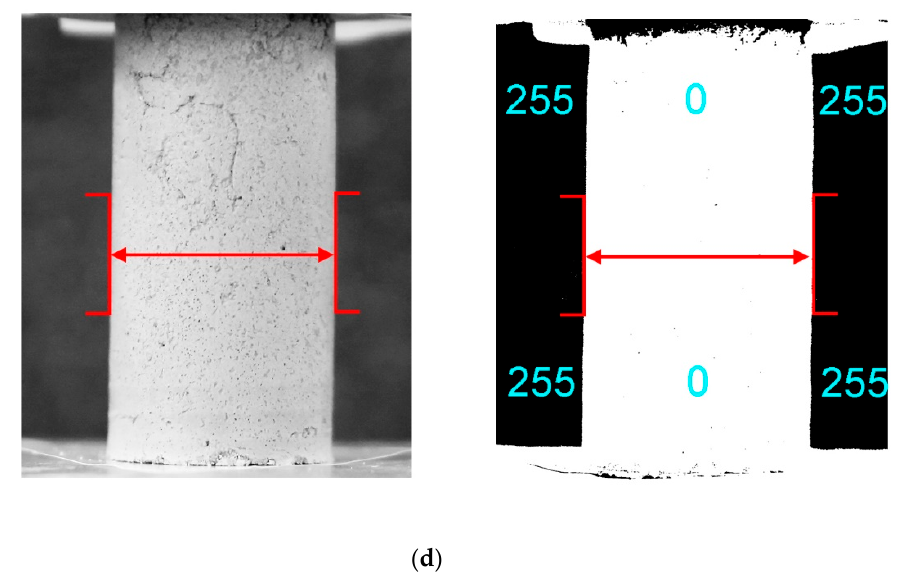
Figure 8. ( a ) The load and displacement curve of mixture MIX-L; ( b ) The load and displacement curve of mixture MIX-M; ( c ) The load and displacement curve of mixture MIX-H. ( d ) An example of a post-processed image obtained with the help of ImageJ.